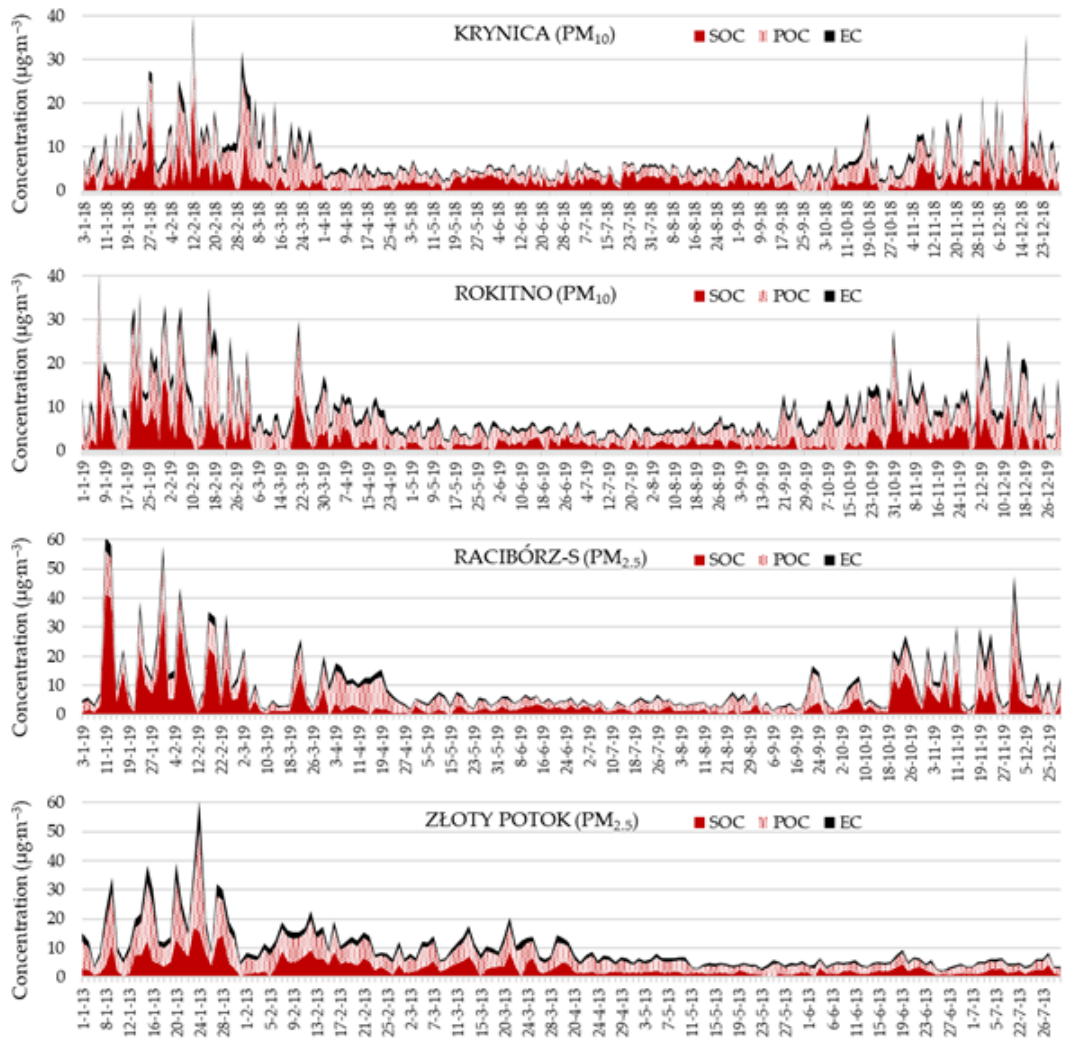
Figure 4. Time series of daily averaged concentrations of SOC, POC and EC (µg·m −3 ) at considered rural background sites.